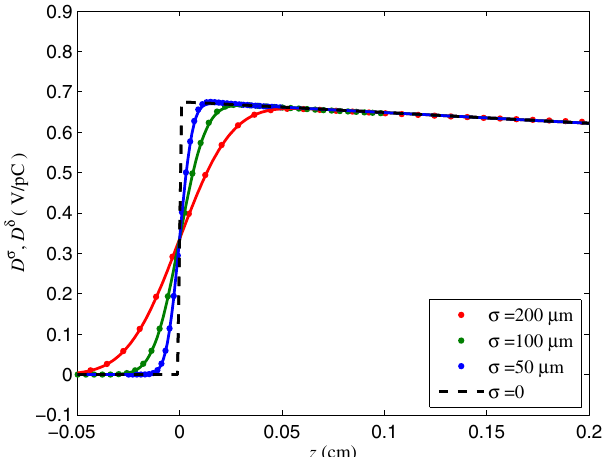
FIG. 7. Cavity functions D (cid:1) ð z Þ calculated directly with ECHO (dots) and reconstructed from W 200 (cid:8) m ECHO